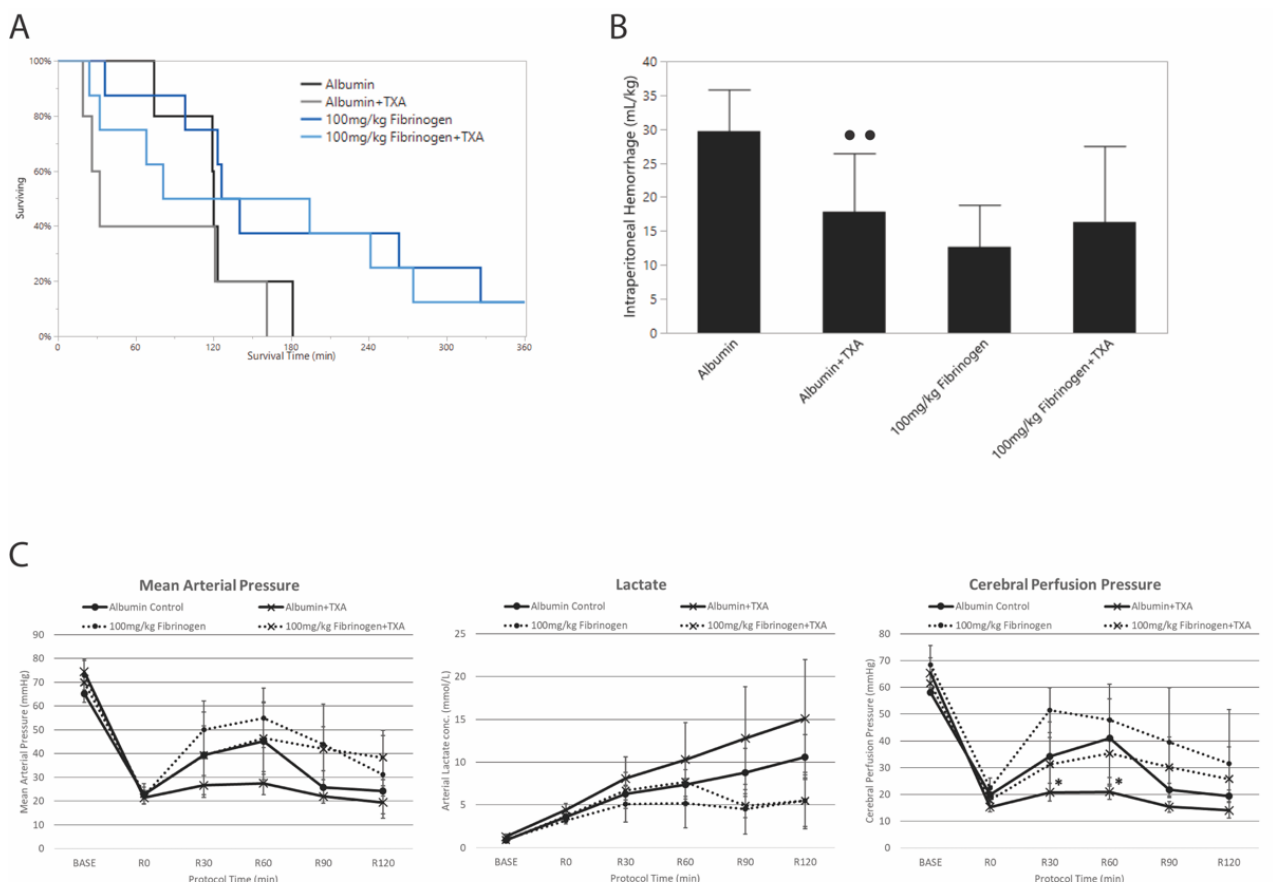
Figure 3. Effect of TXA on survival time ( A ), intraperitoneal blood loss ( B ), and hemodynamics and lactate ( C ). All groups received Hextend and vasopressin. Error bars represent standard deviation. • • and *, p < 0.05 compared to control group without TXA with Tukey HSD adjustment for multiple comparisons.